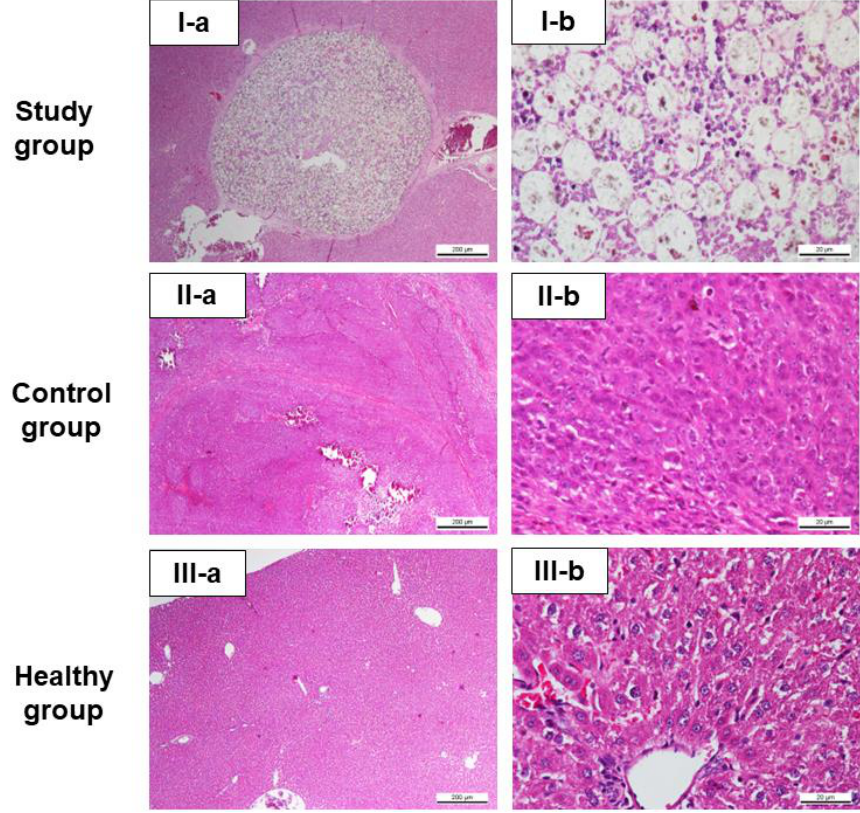
Figure 6. Microphotograph of liver tissue section of the representative rats in all three groups. ( I-a ) and ( I-b ) Study group. ( II-a ) and ( II-b ) Control group. ( III-a ) and ( III-b ) Healthy group.